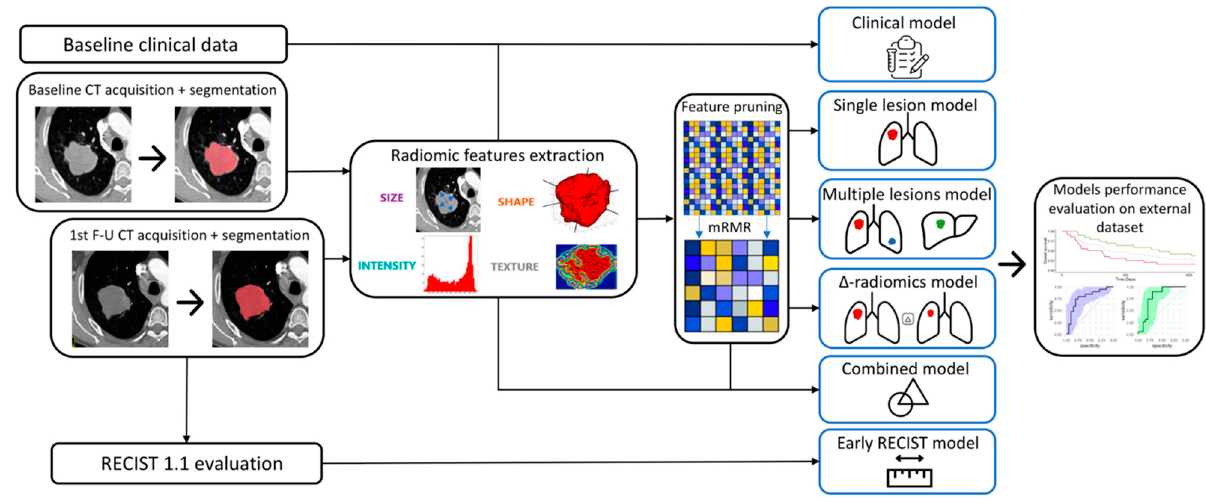
Figure 1. Radiomics workflow of the study.